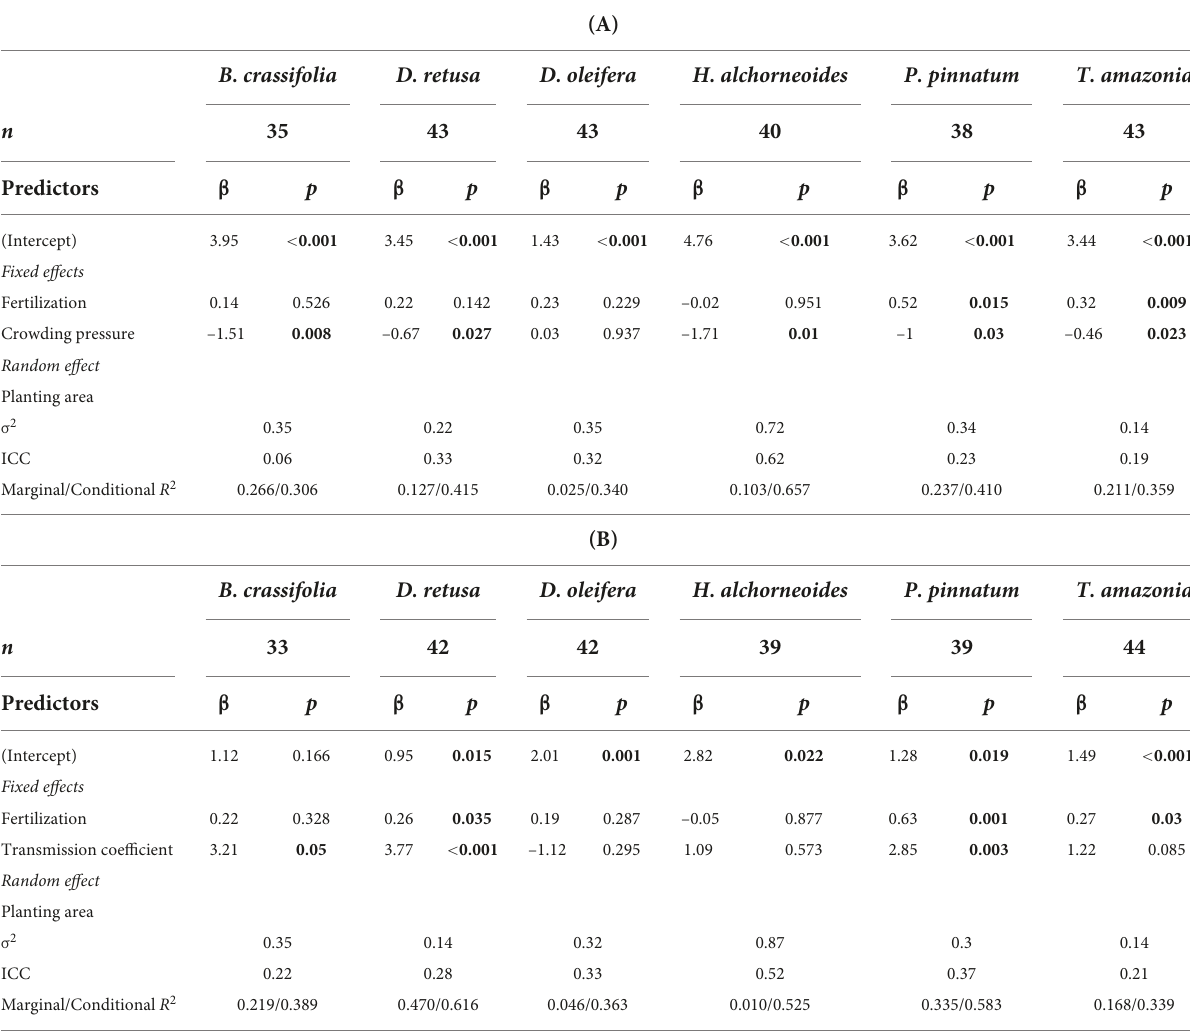
TABLE 5 Summary statistics for the effect of growing environment and fertilizer on BD, with separate tables for crowding pressure (A) and light availability (B) . n , number of observations (plots); β , coefficient estimates; p , p -values ( < 0.05 bolded); σ 2 , random effect variance (the variance explained by planting area); ICC, intra-class correlation coefficient (the proportion of the total variance explained by the random effect); Marginal R 2 is the proportion of variance in BD explained by fixed effects only and conditional R 2 is the proportion of variation explained by the full model (fixed and random effects). Confidence intervals for coefficient estimates available in Supplementary Tables 5A,B